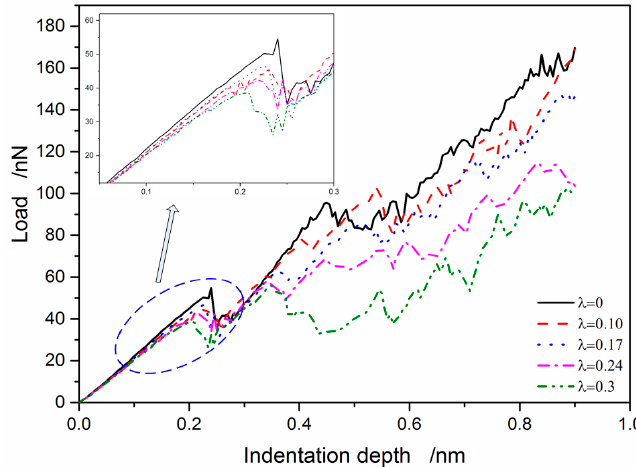
Figure 3. Load vs. indentation depth curves with different tensile residual stress.